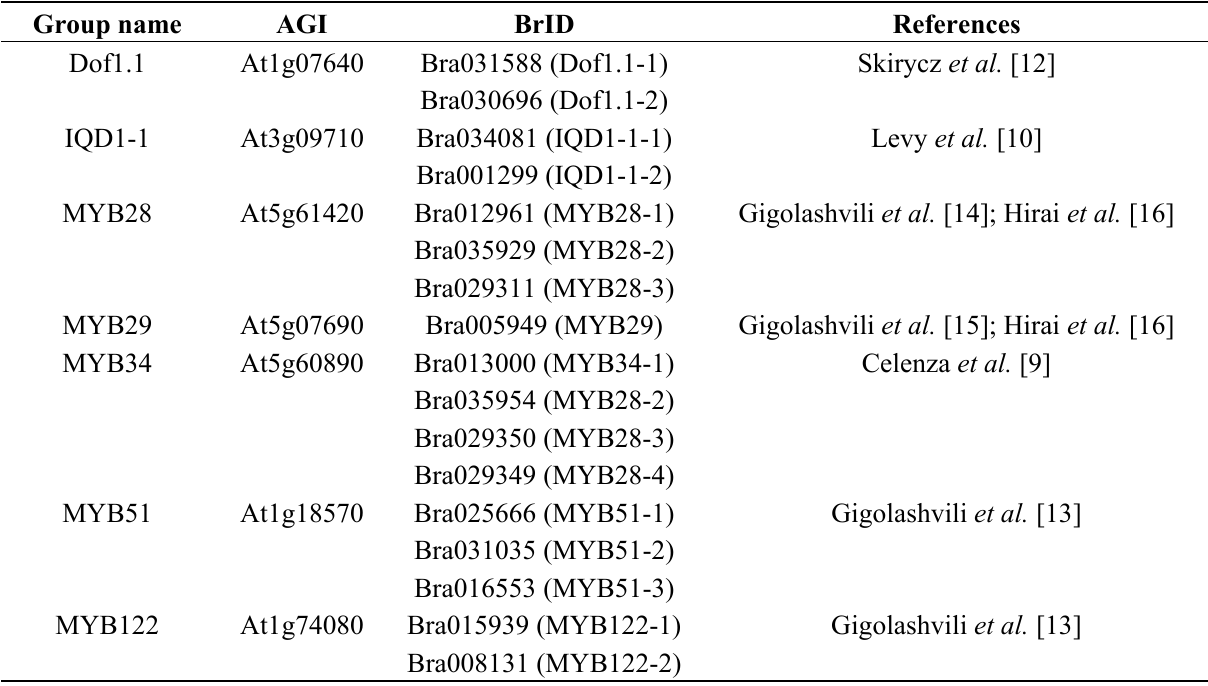
Table 1. Orthologs list of transcription factors involved in GSL biosynthesis in Chinese